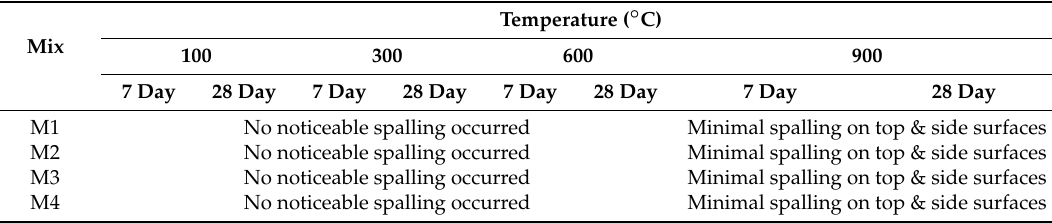
Table 10. Performance of concrete mixtures at high